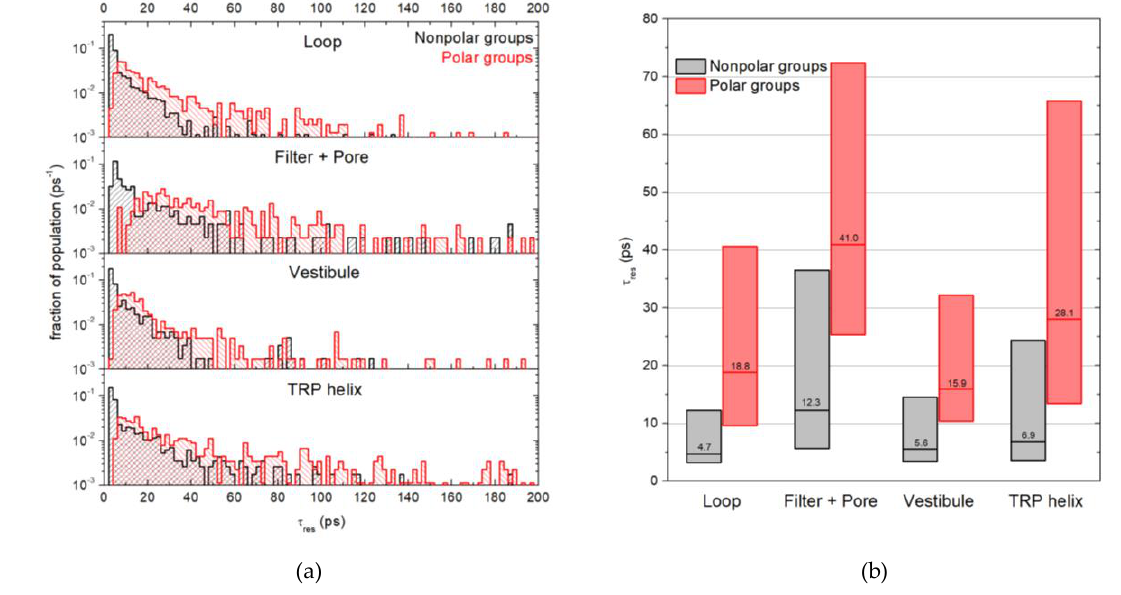
Figure 5. The distributions of the water residence time in hydration shells of polar and nonpolar groups of different TRPV1 domains in a histogram ( a ) and box chart ( b ) representation. Red—polar (and charged) groups, gray—nonpolar groups. Boxes represent interquartile ranges of the corresponding histograms; line and number in each box is the median τ res of the corresponding histogram.